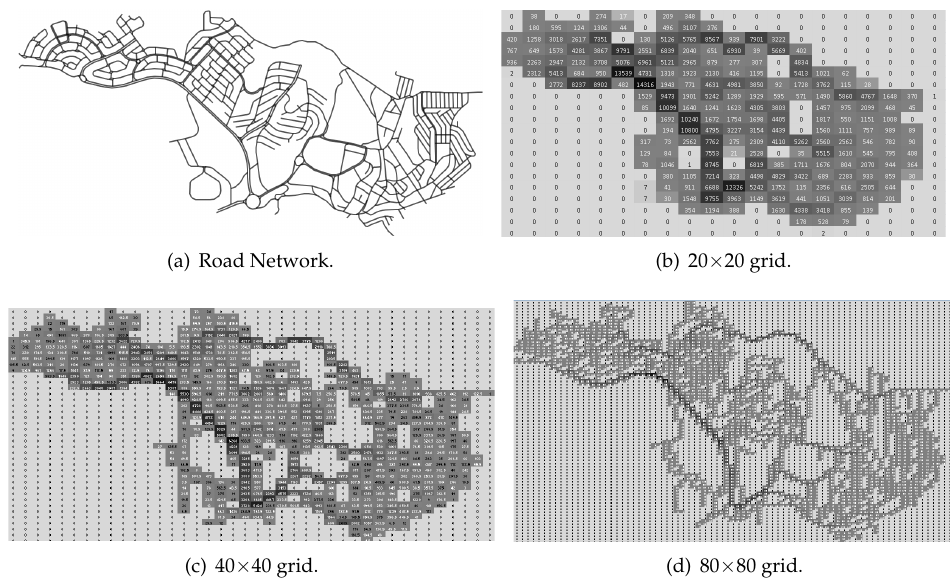
Figure 2. Partitioning the road network in a grid-like structure. Source: [29] With kindly permission.